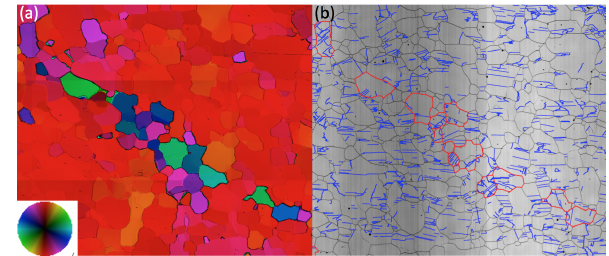
Figure 4. (a) Close-up of tilted-lattice band grains at approximately 1803m depth (bag 3276). Inset shows the colour code for c axes orientation, (b) subgrain structures (blue) visible on LASM (Large Area Scanning Macroscope) data. Black lines indicate grain bound- aries; the red outlines highlight the tilted-lattice band grains.